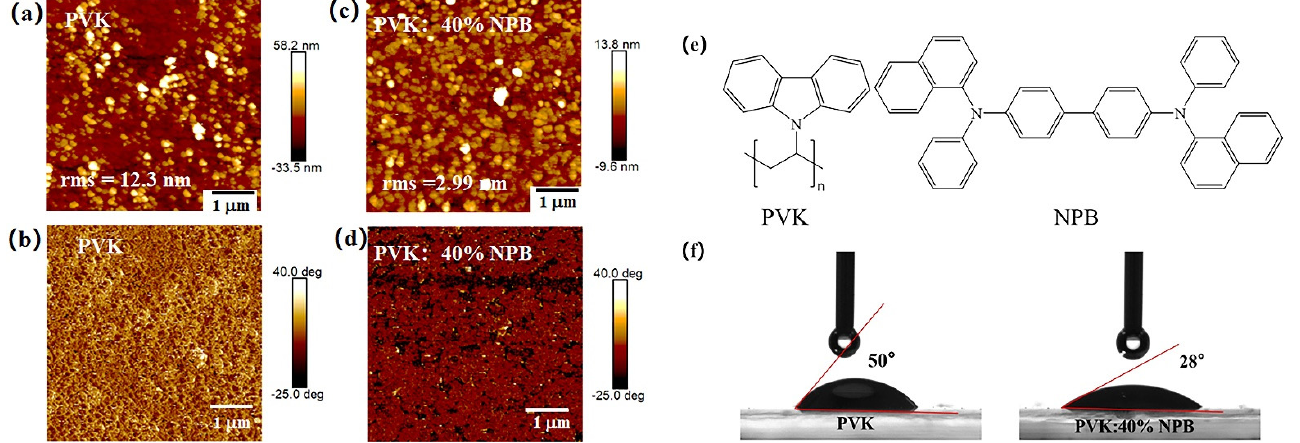
Figure 8. AFM images of HTLs: ( a , c ) height images and ( b , d ) phase images; ( e ) molecular structure of PVK and NPB; and ( f ) contact angles of perovskite precursor solution on HTLs.